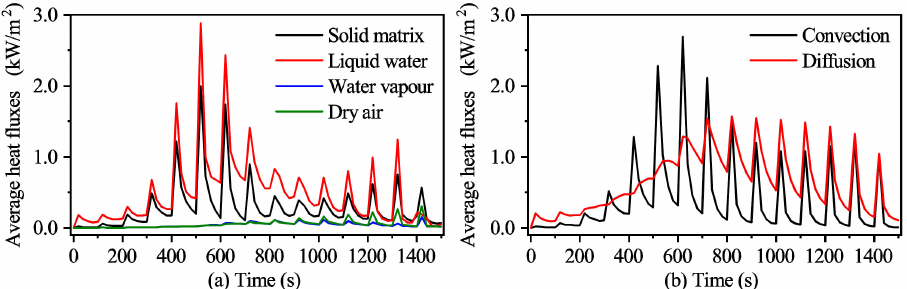
Figure 9. The average heat fluxes of different phases and different driving forces. ( a ) Average heat fluxes by different media. ( b ) Average heat fluxes by convective and diffusion.